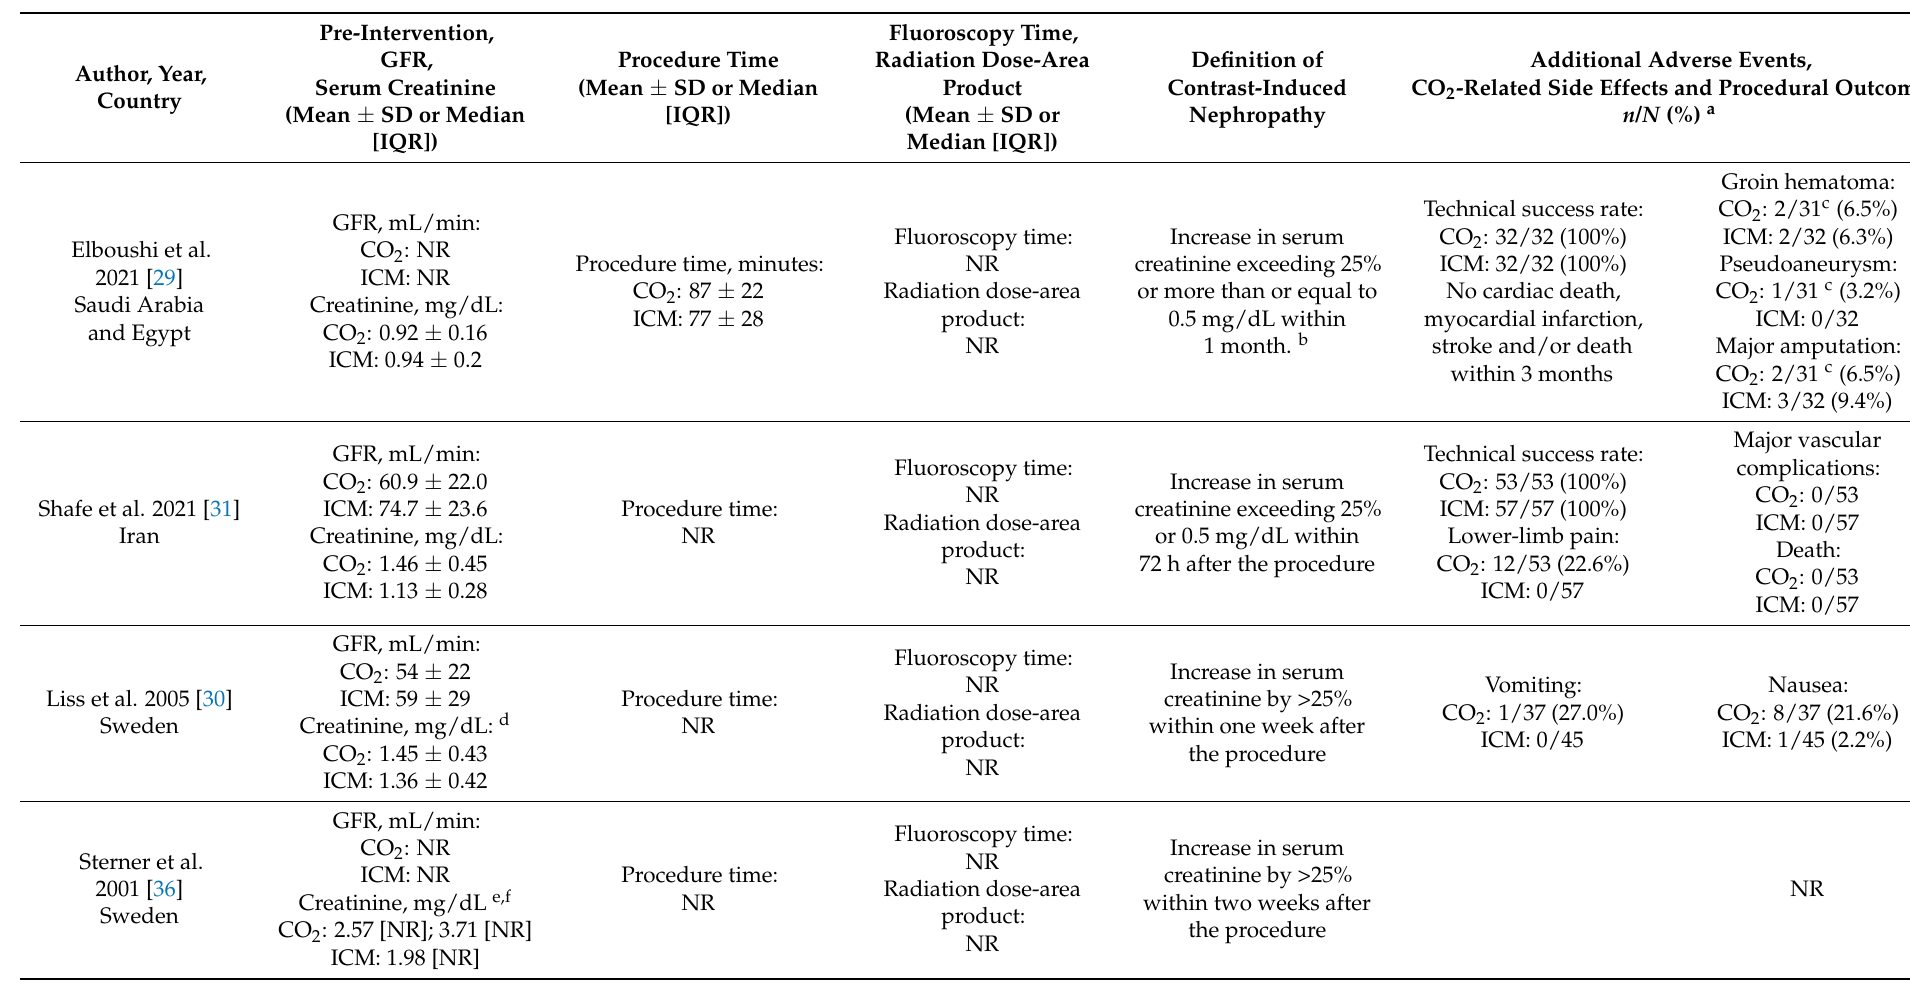
Table A2. Additional characteristics and outcome of the included